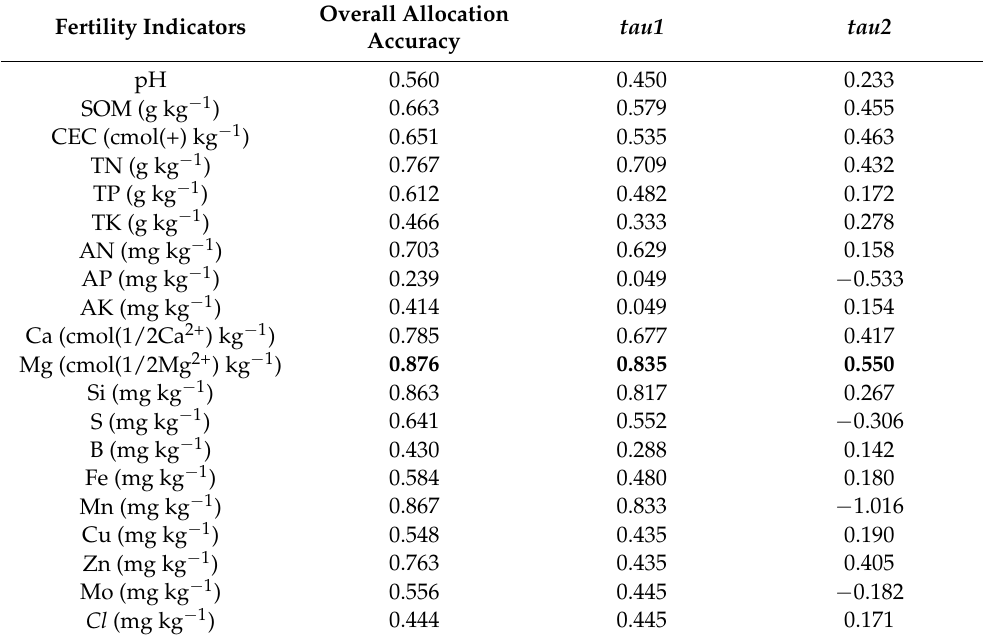
Table 5. Allocation accuracy of individual soil fertility class based on predictions from PLSR models (five fertility classes). Overall Allocation Fertility Indicators